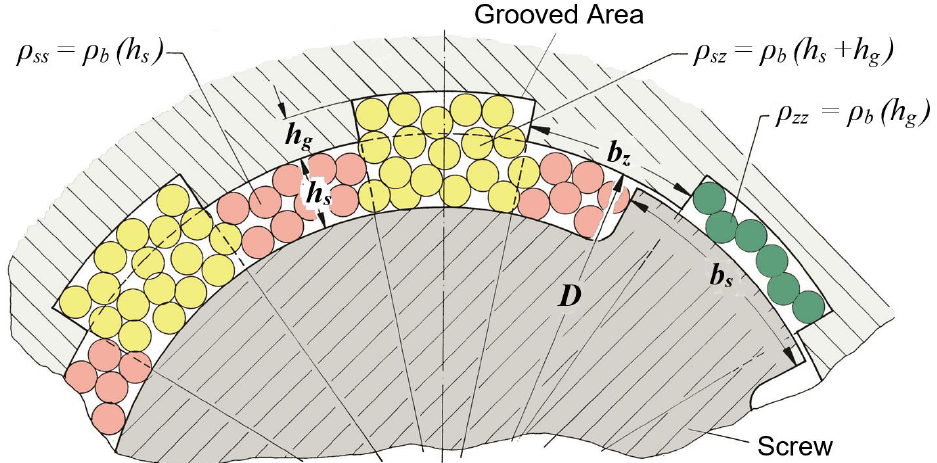
Figure 1. Schematic representation of three different areas exhibiting varying bulk densities due to different dumping heights in a grooved solid conveying zone. Drawn and kindly provided with the permission to use by E. Grünschloß (author of [10]), March, 2022.